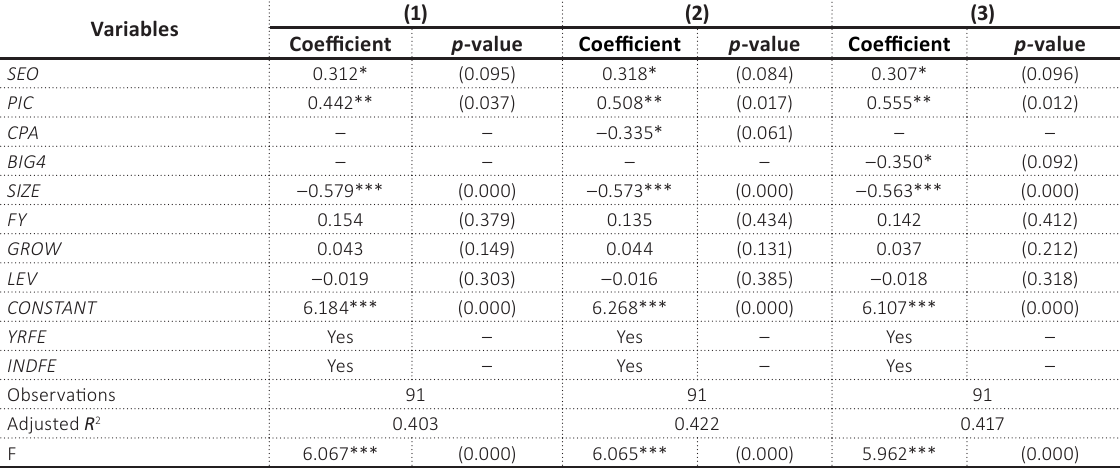
Table 6. Main results for H1 ( DA and SEO